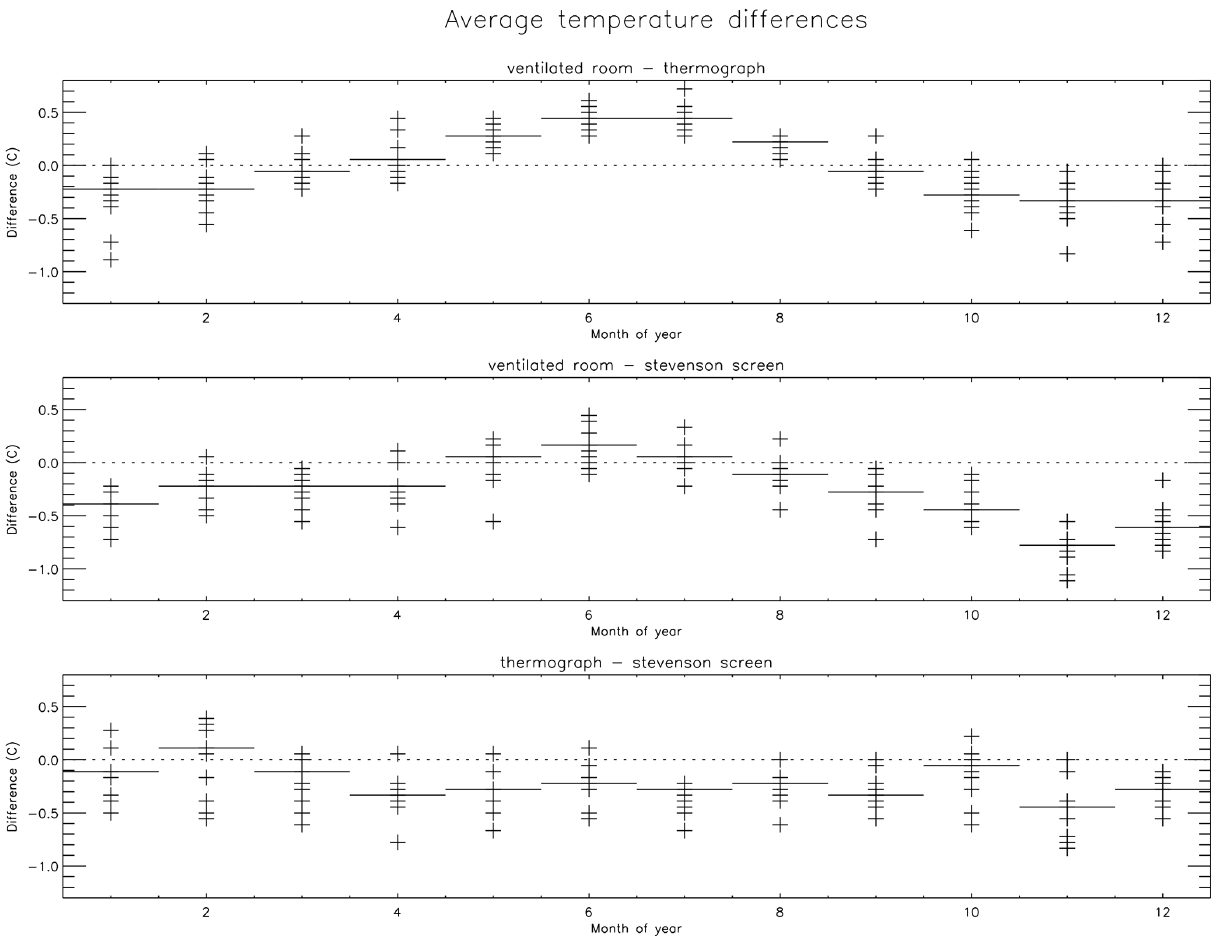
Figure 16. As Fig. 12 but for Ta. Axis labels are identical across the three panels but differ from those in Figs. 12 and